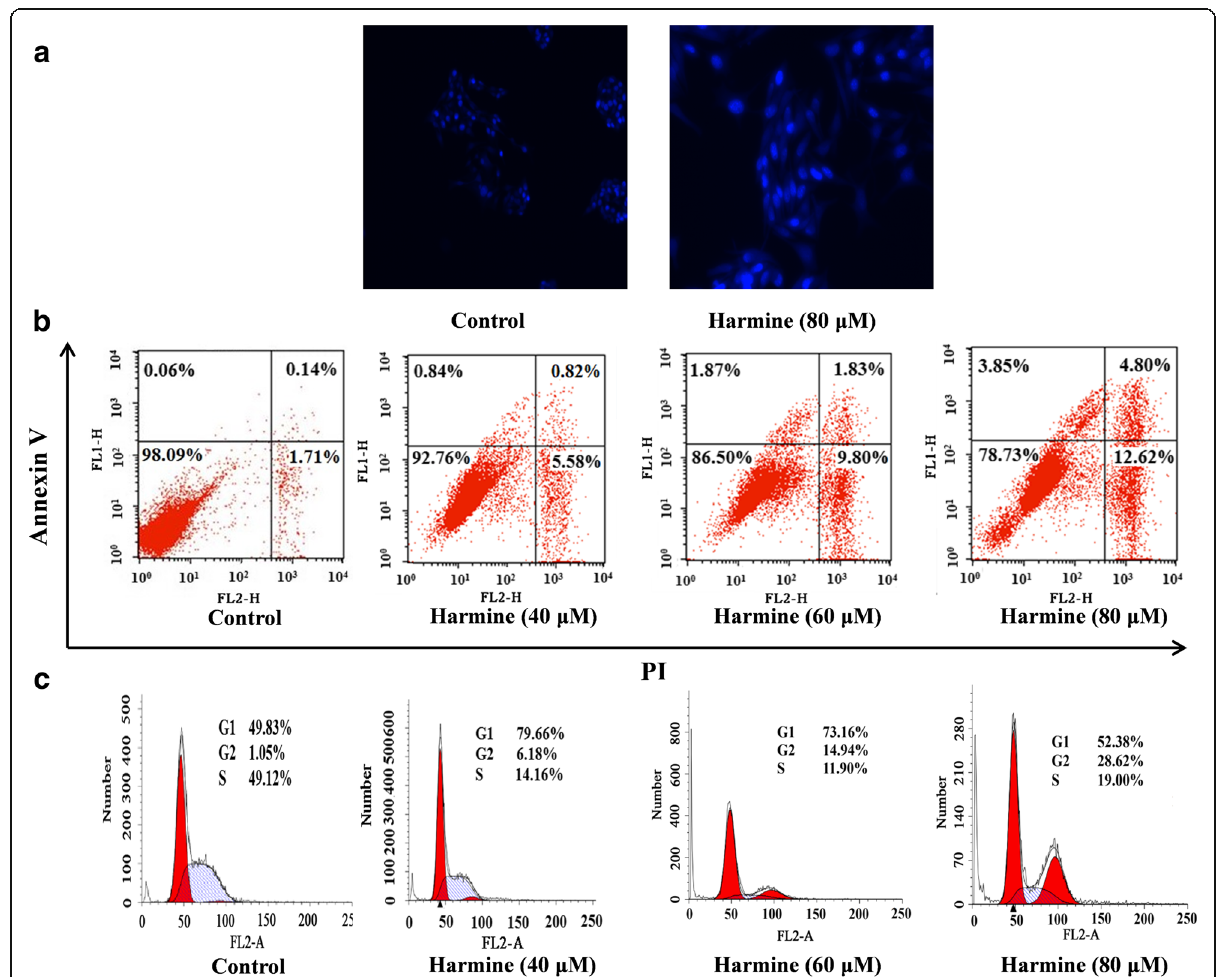
Fig. 4 Harmine induced apoptosis in B16 cells. a: Fluorescence microscope (magnification, × 200) assessed by hoechst 33,258 staining; b: Apoptotic cells detected by flow cytometry with annexinV-FITC and PI double staining; and c: Images of harmine induced cell cycle arrest analysis detected by PI